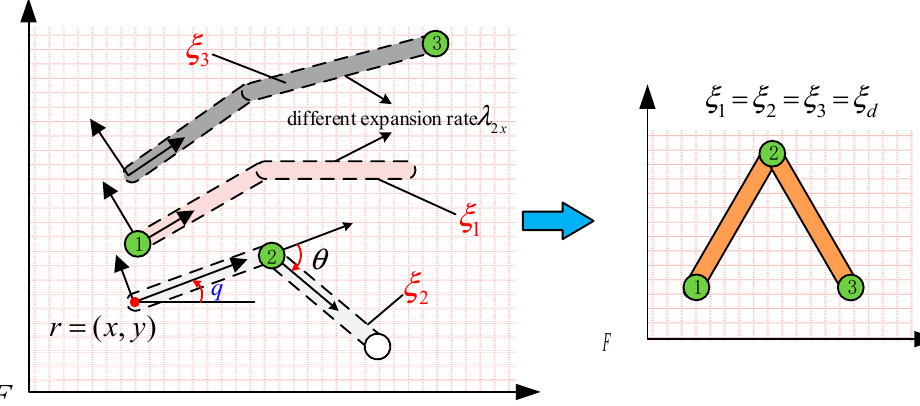
Figure 4. Implication of virtual linkage states ξ i